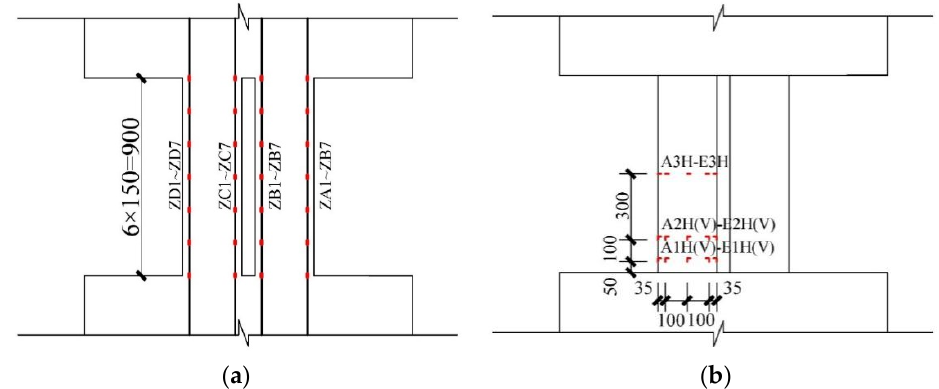
Figure 5. Locations of strain gauges: ( a ) for longitudinal steel bar; ( b ) for PET sheet.